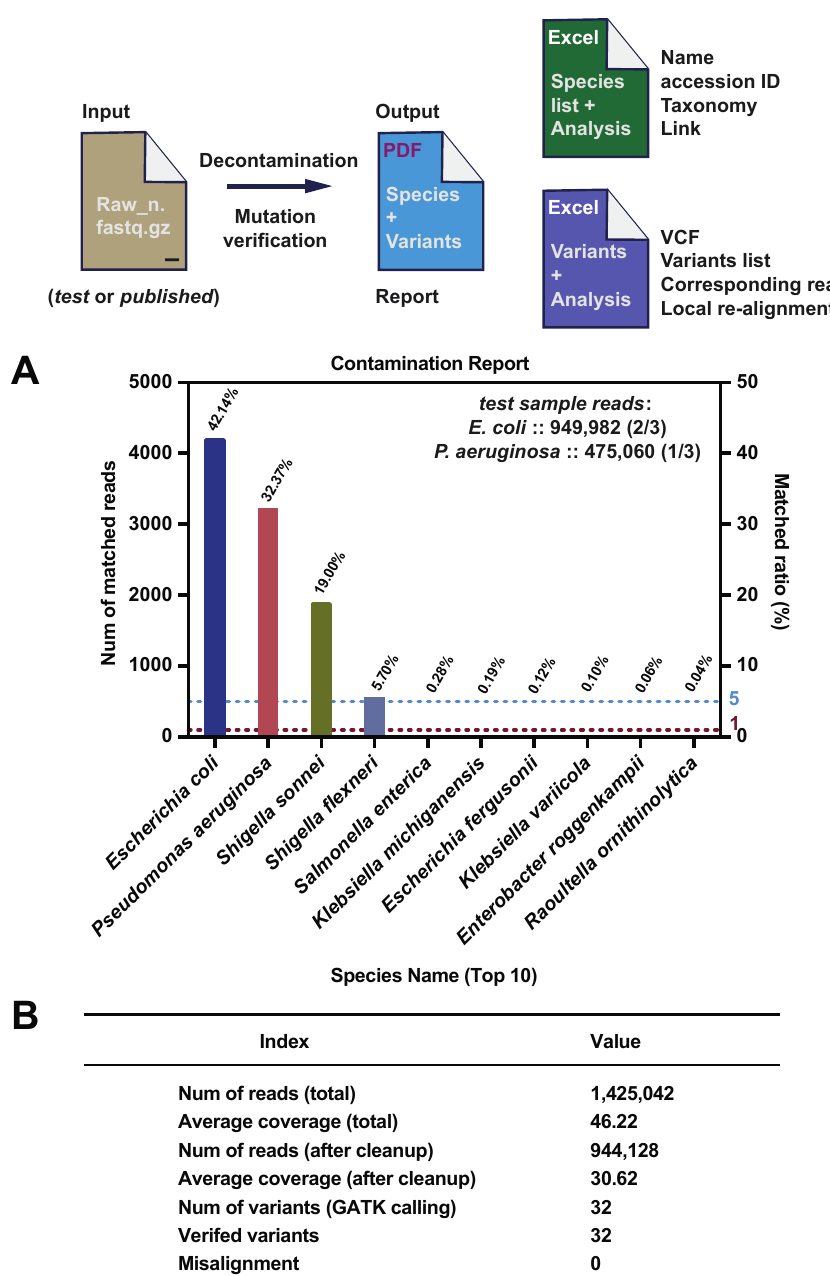
Figure 4. Performance of CleanSeq on the simulated dataset mimicking bacterial contamination. The contamination test set was a reads mixture of E. coli and P. aeruginosa in a ratio of 2:1, with E. coli as the target bacteria and P. aeruginosa as the contaminating bacteria. The analytical flow and species reports were shown in ( A ). Detailed statistical results of the cleanup and mutation calling were listed in ( B ).